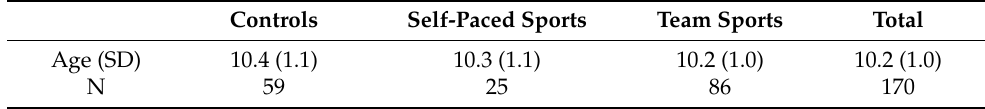
SD = Standard deviation, N = Number of